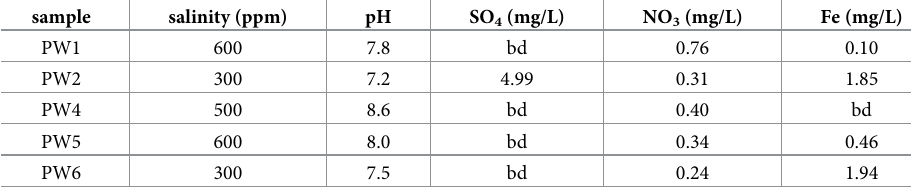
Table 4. The salinity, pH and the dissolved compound concentrations of produced water.